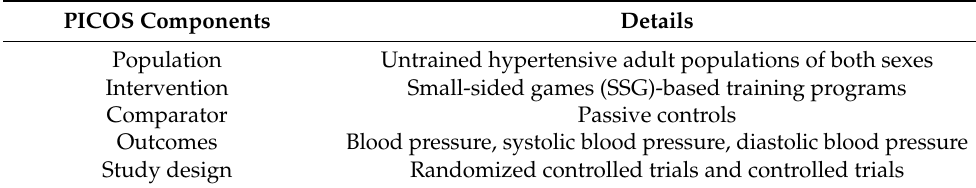
Table 1. Population, Intervention, Comparator, Outcomes, Study design (PICOS)